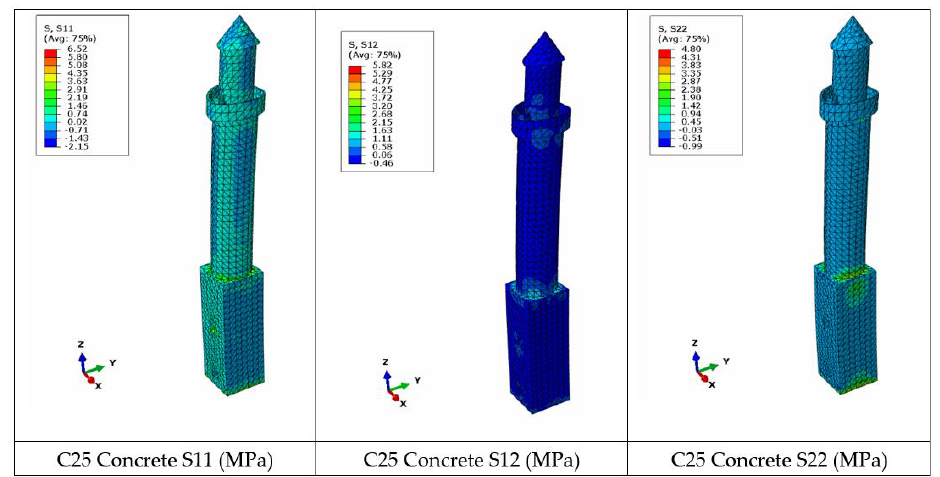
Figure 15. Stress diagrams for C25 concrete (H = 25.40 m). Table 13. Comparison of the analysis results for different material types (H = 25.40